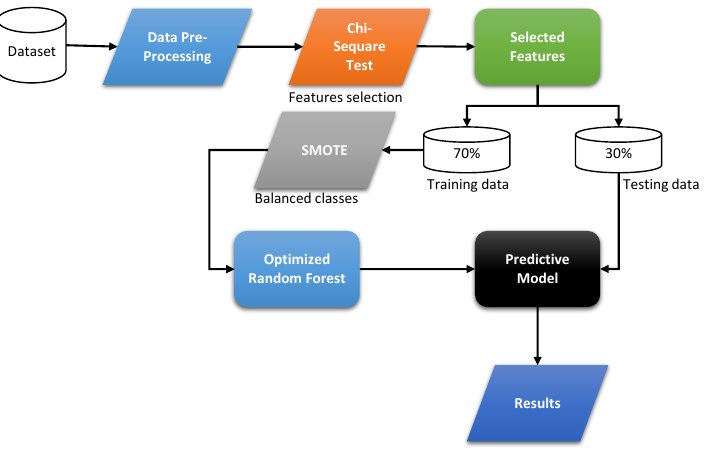
Figure 2. Flowchart of the proposed model χ 2 _RF.